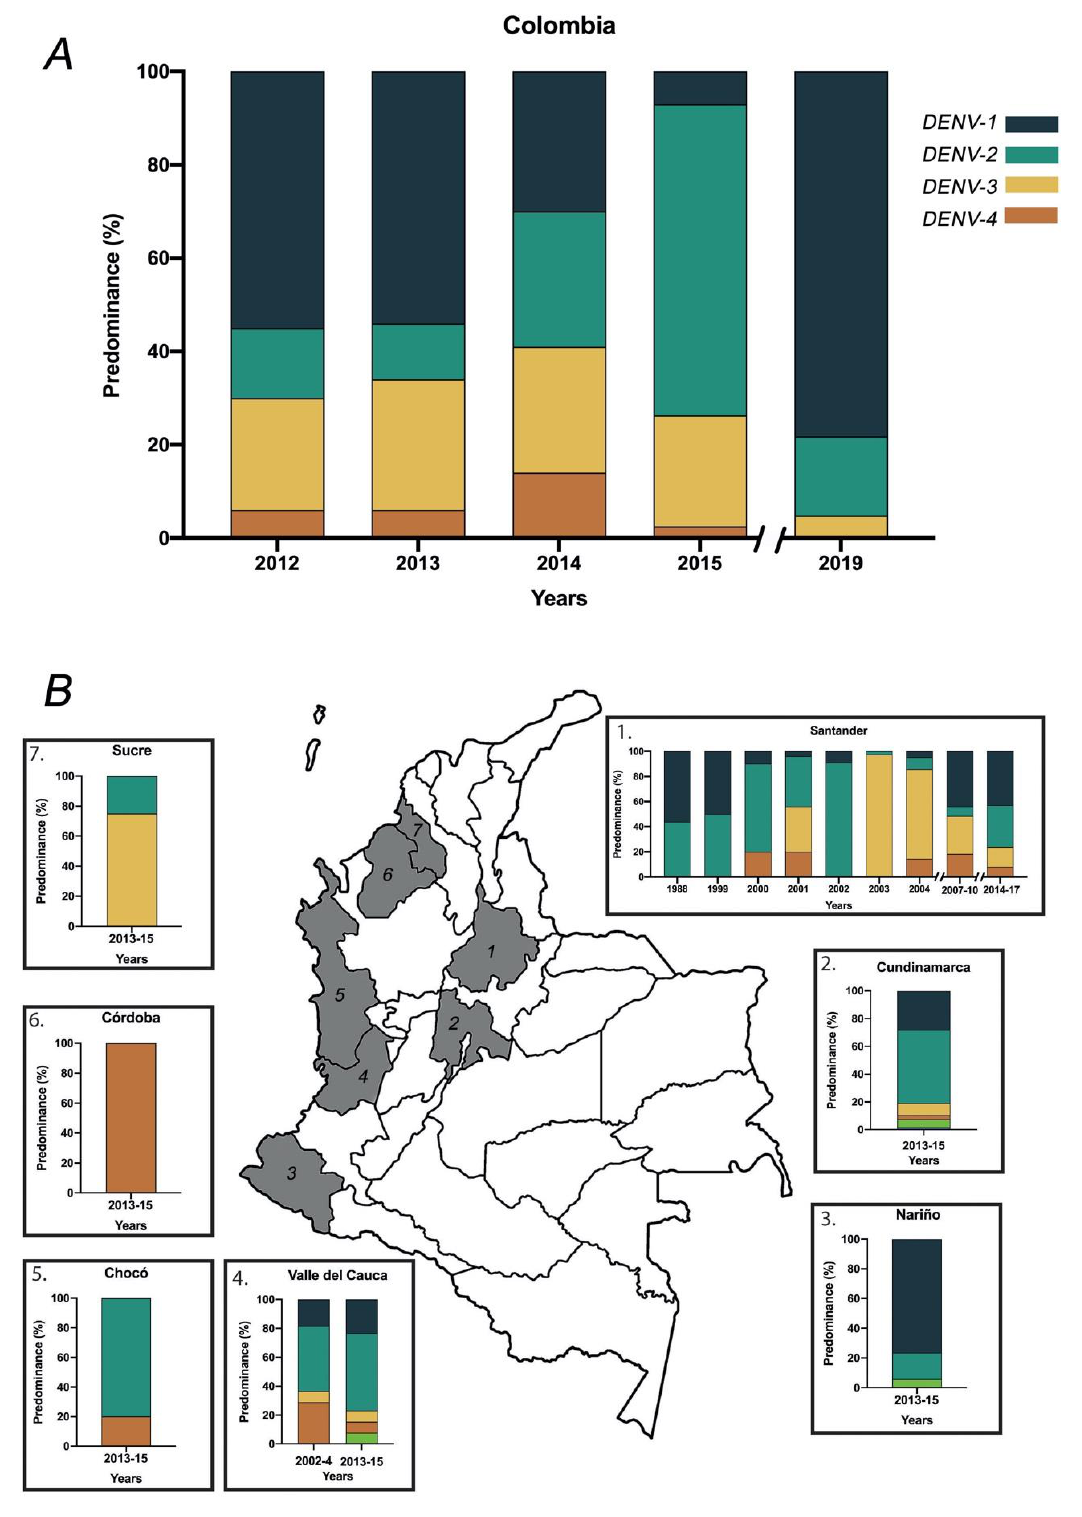
Figure 6. Predominance of the dengue virus by serotypes in Colombia: Predominance rate by serotypes in Colombia by year ( A ); The predominance of dengue virus serotypes by departments in different years ( B ) [14,15,22 − 24,28,35 − 37].